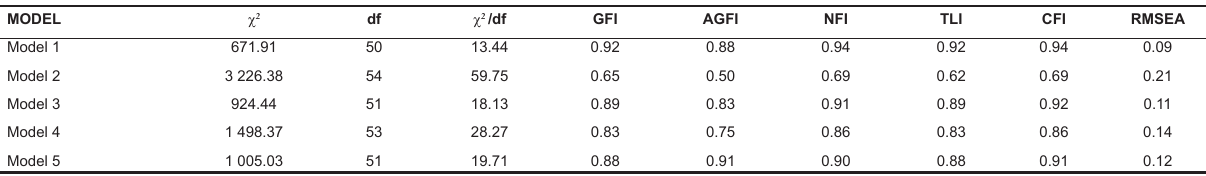
TABLE 2 Goodness-of-fit statistics for the hypothesised PEQ